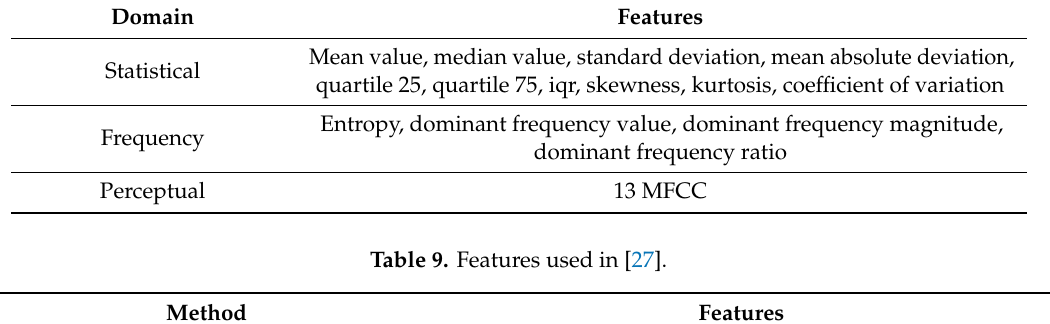
Table 8. Features used in [26].